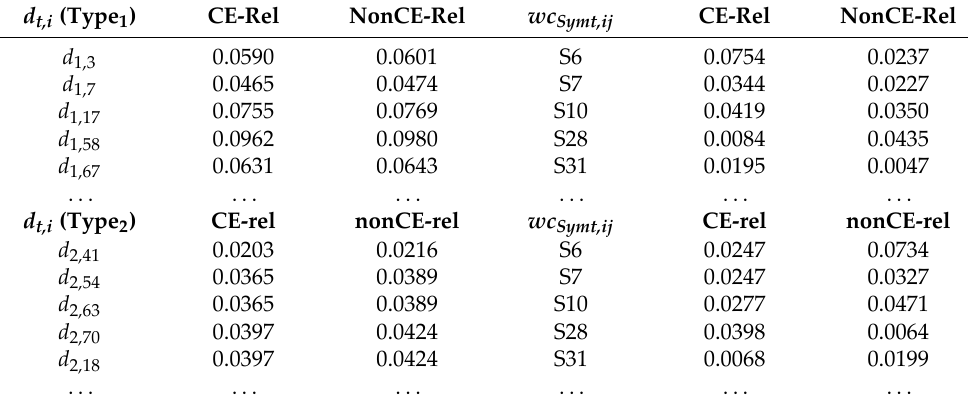
Type 1 and Type 2 disease documents (where the values of the d t,i features and the wc Symt,ij features with the symptom‑concept codes are d 1,3 = HepatitisB, d 1,7 = German‑measles, d 1,17 =